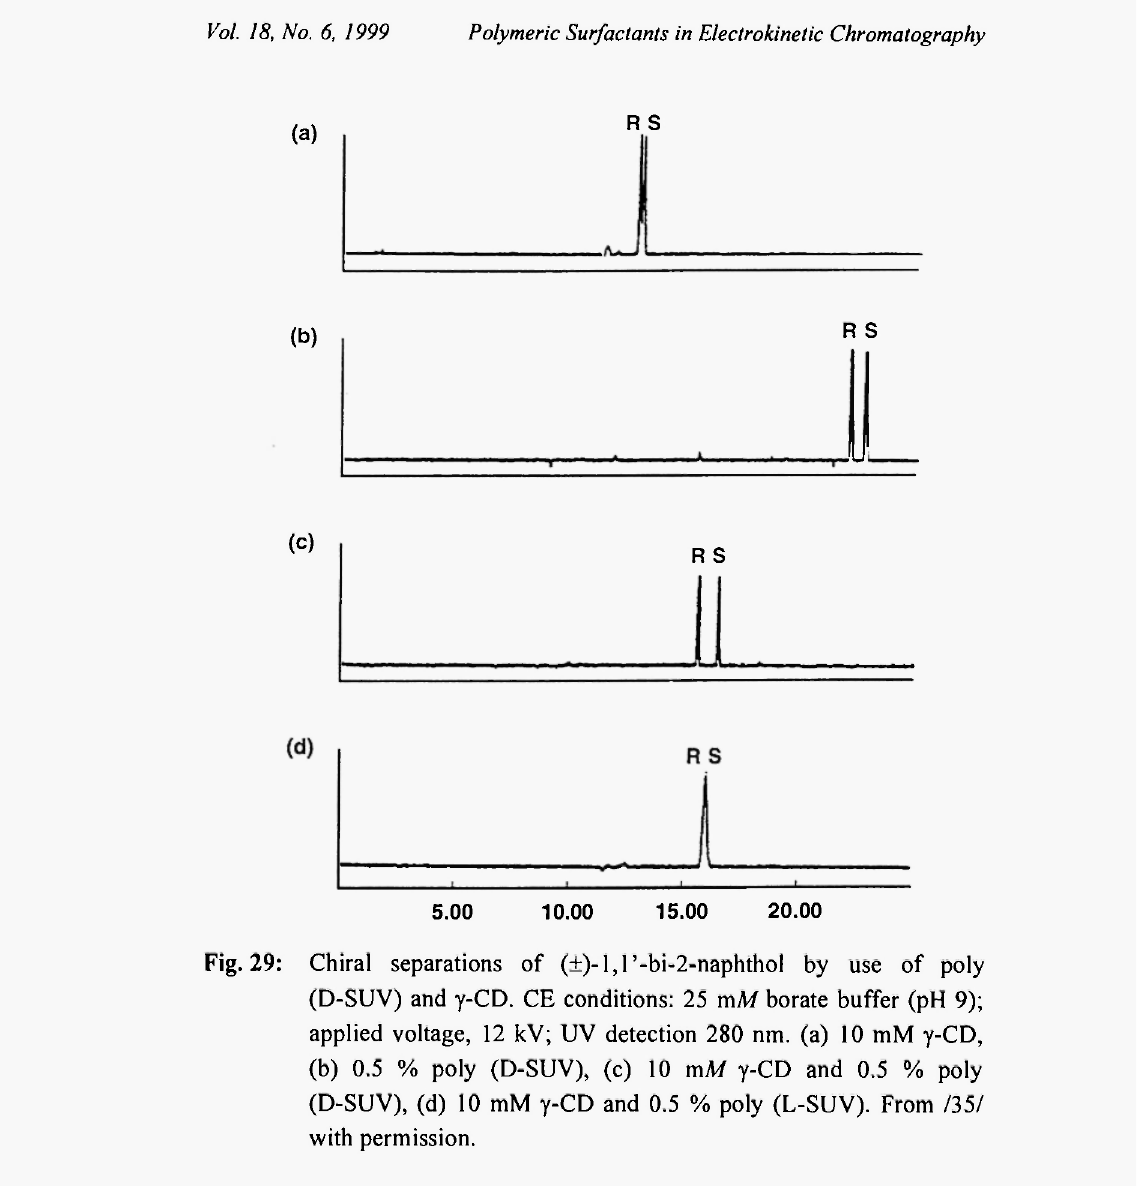
Fig. 29: Chiral separations of (±)-l,l'-bi-2-naphthoI by use of poly (D-SUV) and γ-CD. CE conditions: 25 mΜ borate buffer (pH 9); applied voltage, 12 kV; UV detection 280 nm. (a) 10 mM γ-CD, (b) 0.5 % poly (D-SUV), (c) 10 mΜ γ-CD and 0.5 % poly (D-SUV), (d) 10 mM γ-CD and 0.5 % poly (L-SUV). From /35/ with